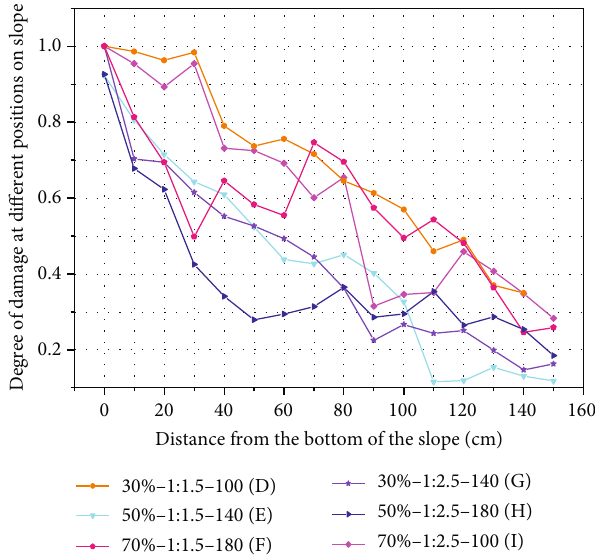
Figure 7: Curves representing the degree of damage at di ff erent positions of